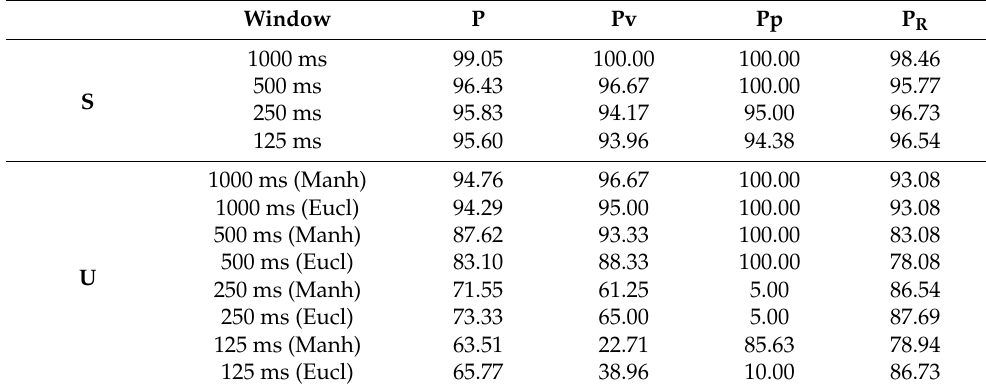
Table 5. Classification performances for VPR scheme.